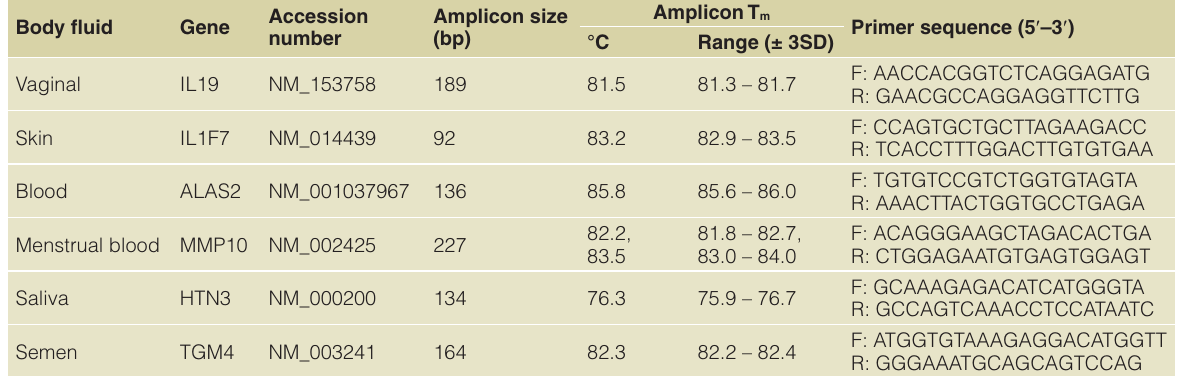
Table 1. Genes and amplicons used in singleplex, duplex and triplex body fluid HRM assays. Body